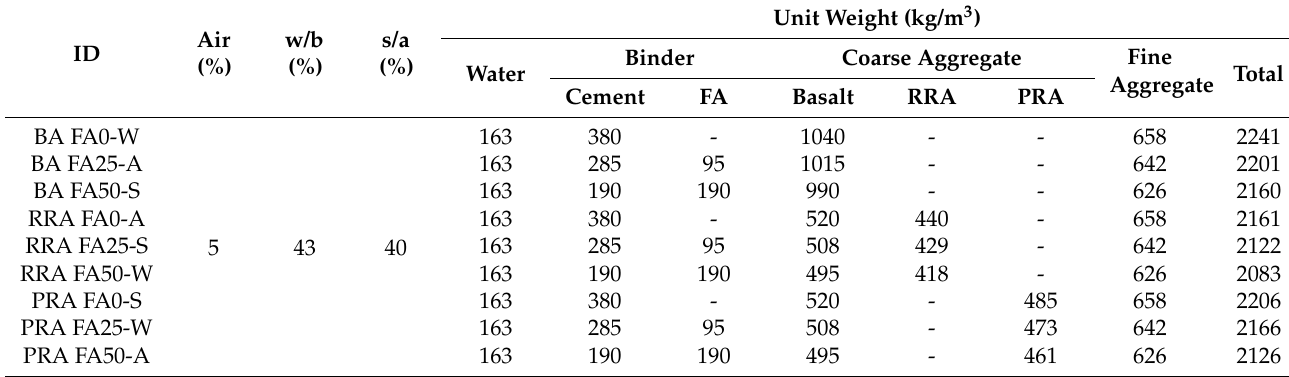
Table 2. Mix proportion of concrete.